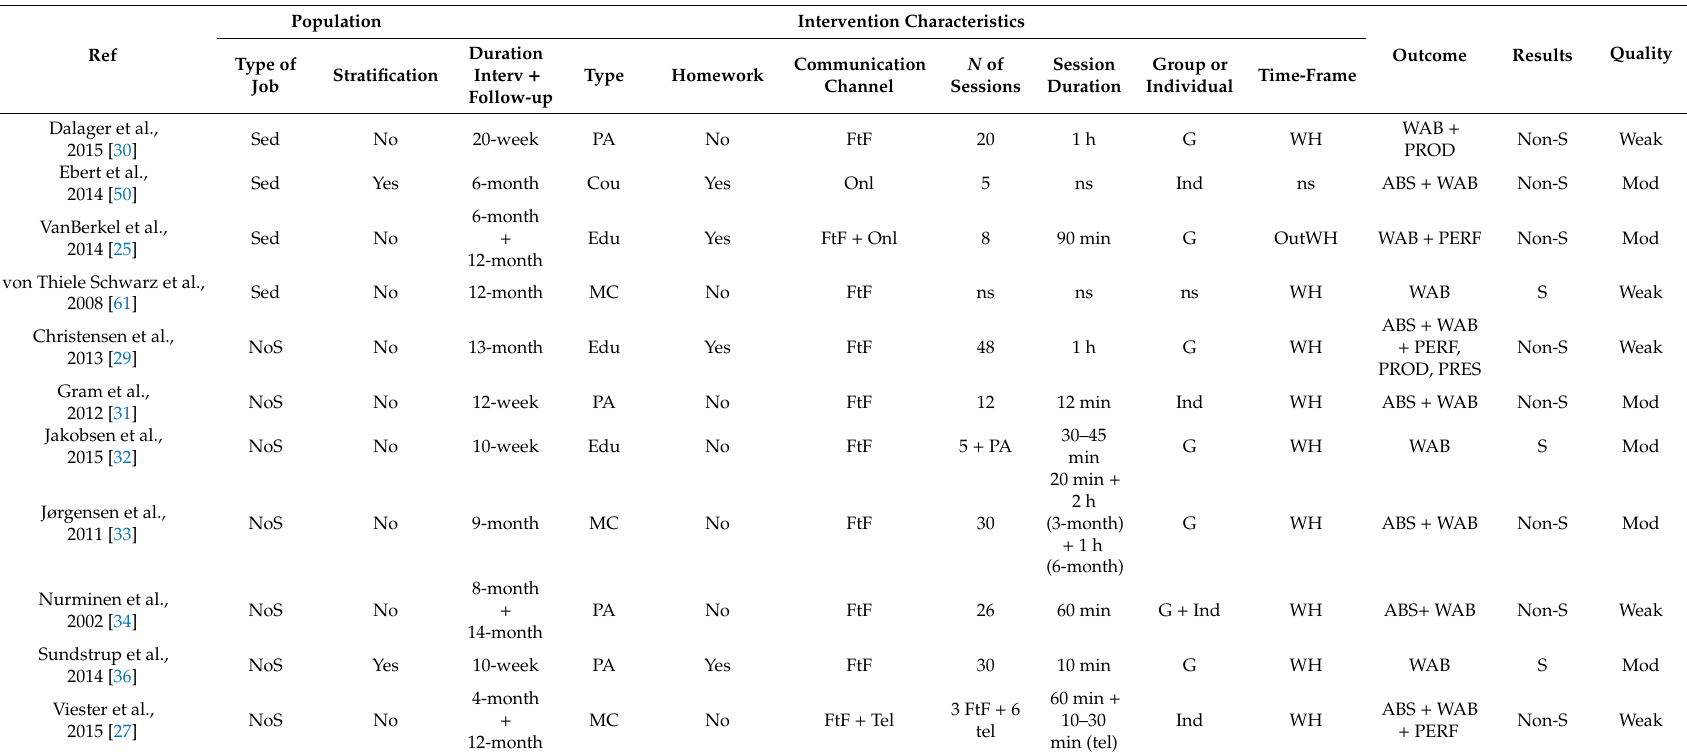
Table 2. Intervention characteristics of the RCTs included in the systematic review focus on improving work